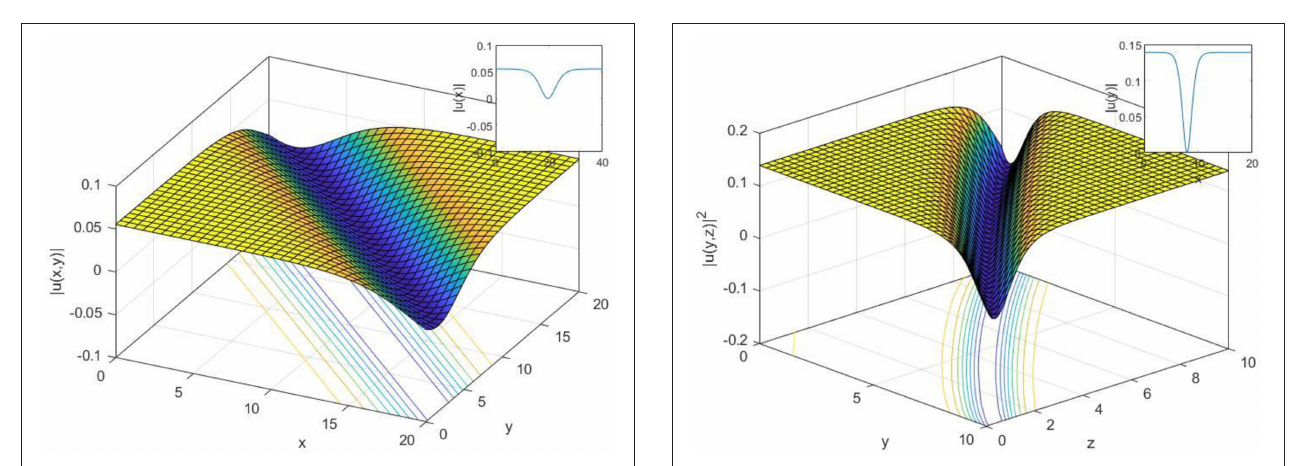
3, µ 2, β 0.6, α 0.9, ε 0.2, c 0.3, t 2, γ 3 and z = = = = = = = =